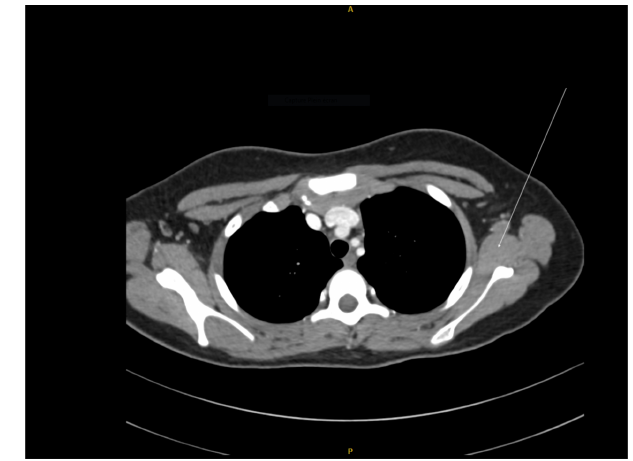
Figure 1. Thoracic CT scan. The arrow shows the left axillary gan- glion. Origin and source of radiology image: Department of Radi- ology CHU Dijon.